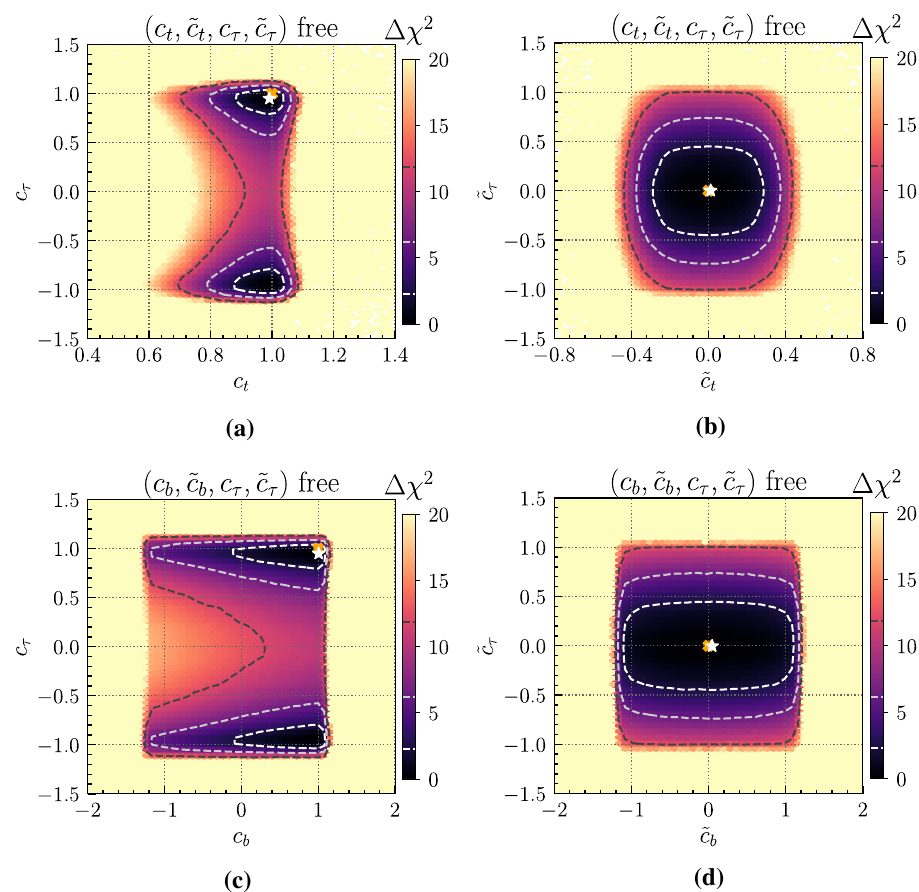
Fig. 5 2-flavor models ( t + τ, b + τ ): results of fits to the LHC measurements in the a ( c t , c τ ), b ( ˜ c t , ˜ c τ ), c (, ‘ c τ ), and d ( ˜ c b , ˜ c τ ) parameter planes. In each case, the CP -even and CP -odd parts of the couplings shown in the plot are free-floating while all the other parameters are set to their SM values. The legend corresponds to the one in Fig.